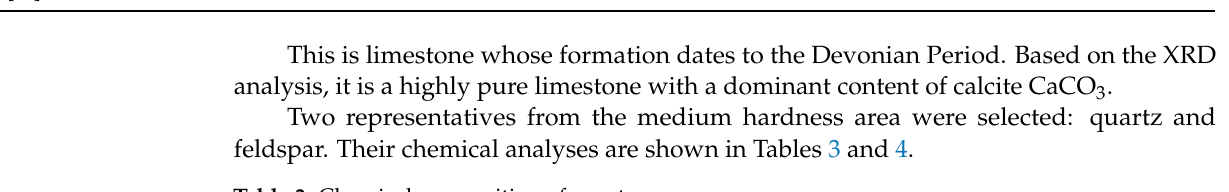
Table 3. Chemical composition of